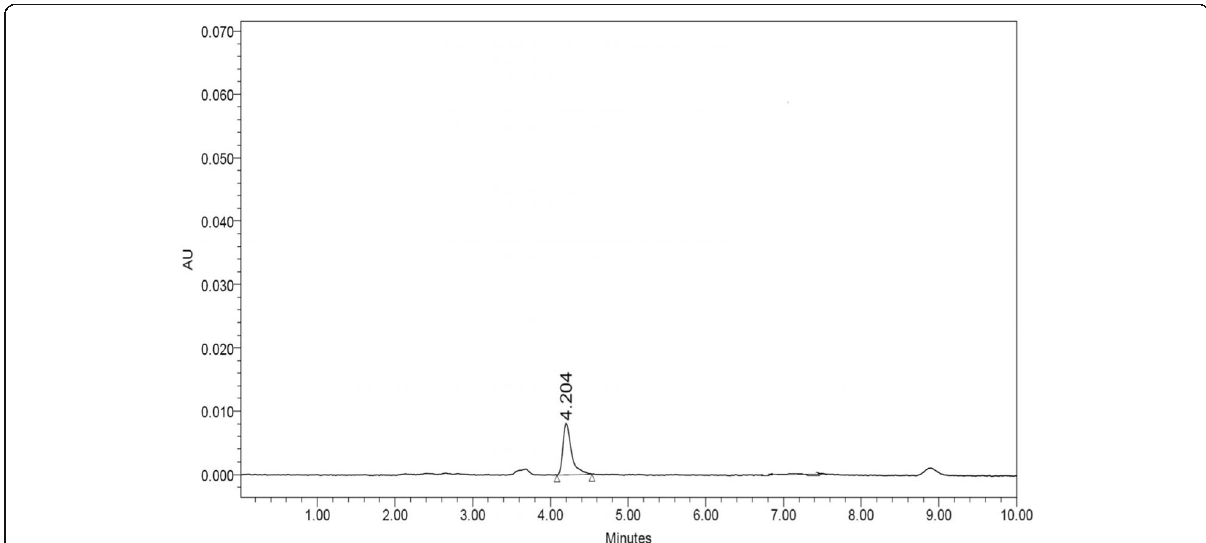
Fig. 2 Chromatogram showing absence of peak of naringenin of blank nanoparticles. The peak shown here depicts that of excipients present in